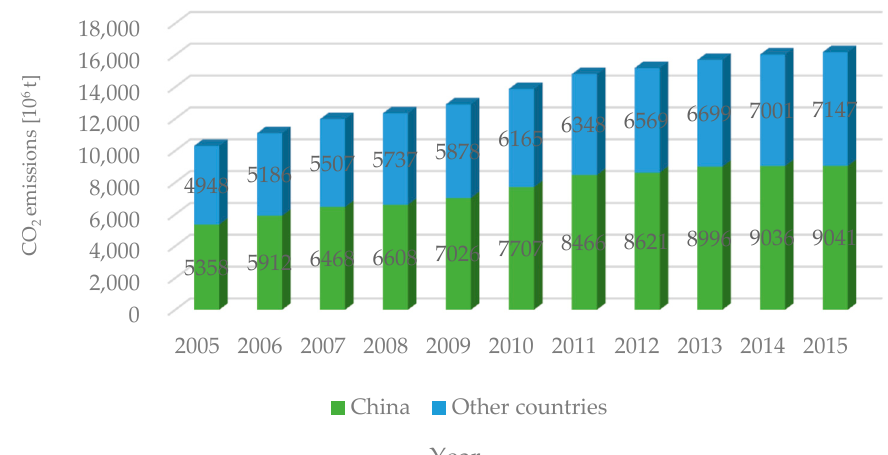
Figure 1. 2005–2015 BRI national carbon emissions.